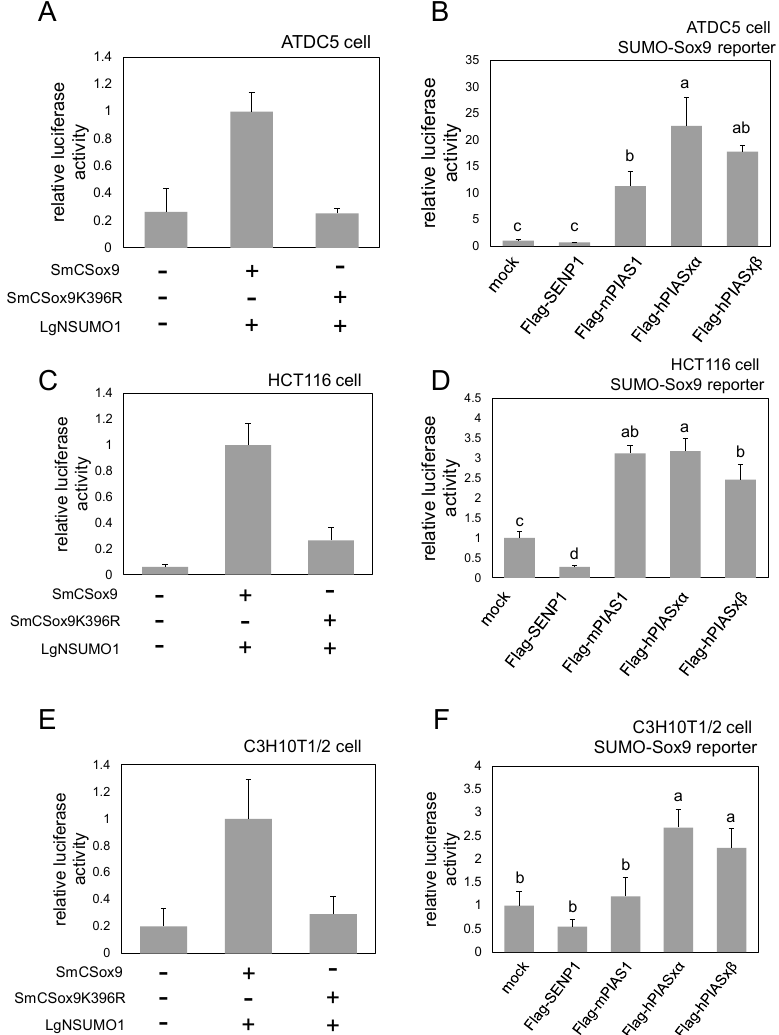
Figure 3. SUMO-Sox9 reporter activity in ATDC5, HCT116 and C3H10T1/2 cells. ( A ) A luciferase assay to examine the SUMOylation-dependent activity of SUMO-Sox9 reporter in ATDC5 cells. Bars indicate the mean value of triplicate wells. Error bars indicate the standard deviation. ( B ) A luciferase assay to examine whether or not the SUMO-Sox9 reporter activity could be upregulated with the promotion of Sox9 SUMOylation and downregulated with the Sox9 deSUMOylation in ATDC5 cells. Bars indicate the mean value of triplicate wells. Error bars indicate the standard deviation. The mean values sharing a letter did not differ to a statistically significant extent ( p ≥ 0.05, Tukey’s HSD test). ( C ) A luciferase assay to examine the SUMOylation-dependent activity of SUMO-Sox9 reporter in HCT116 cells. Bars indicate the mean value of triplicate wells. Error bars indicate the standard deviation. ( D ) A luciferase assay to examine whether or not the SUMO-Sox9 reporter activity could be upregulated with the promotion of Sox9 SUMOylation and downregulated with Sox9 deSUMOylation in HCT116 cells. Bars indicate the mean value of triplicate wells. Error bars indicate the standard deviation. The mean values sharing a letter did not differ to a statistically significant extent ( p ≥ 0.05, Tukey’s HSD test). ( E ) A luciferase assay to examine the SUMOylation-dependent activity of SUMO-Sox9 reporter in C3H10T1/2 cells. Bars indicate the mean value of triplicate wells. Error bars indicate the standard deviation. ( F ) A luciferase assay to examine whether or not the SUMO-Sox9 reporter activity could be upregulated with the promotion of Sox9 SUMOylation and downregulated with the Sox9 deSUMOylation in C3H10T1/2 cells. Bars indicate the mean value of triplicate wells. Error bars indicate the standard deviation. The mean values sharing a letter did not differ to a statistically significant extent ( p ≥ 0.05, Tukey’s HSD test). All of the experiments were repeated at least twice, and representative results are shown.